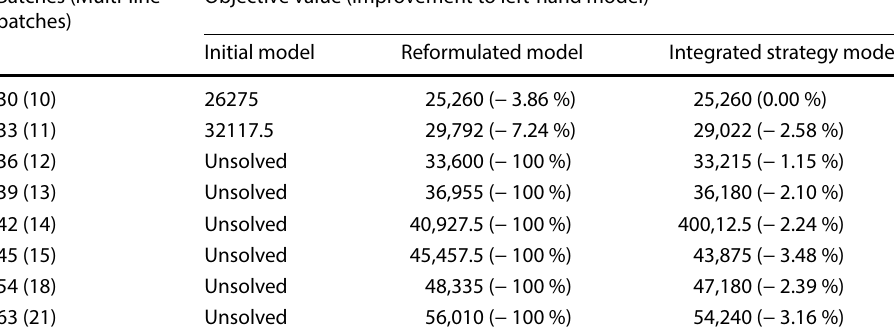
Table 8 Model comparison Batches (Multi-line